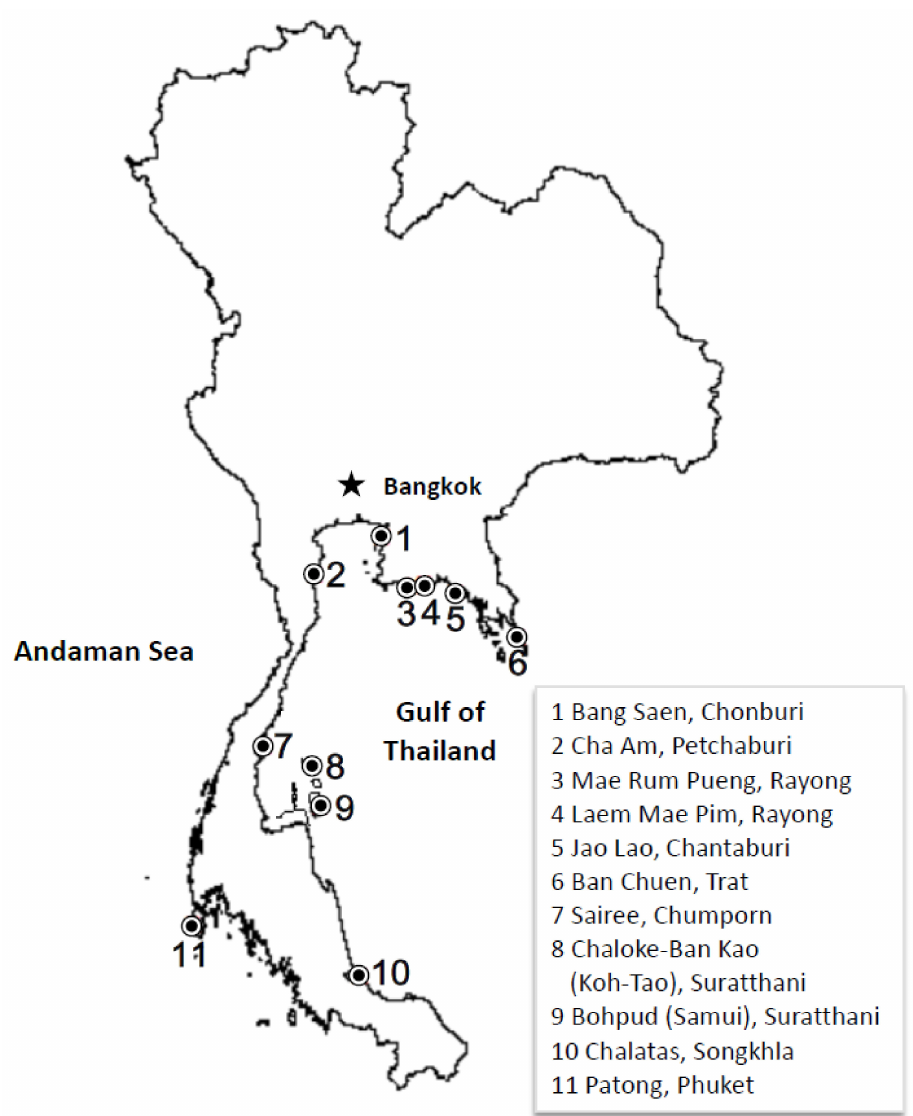
Figure 1. Map of Thailand showing study